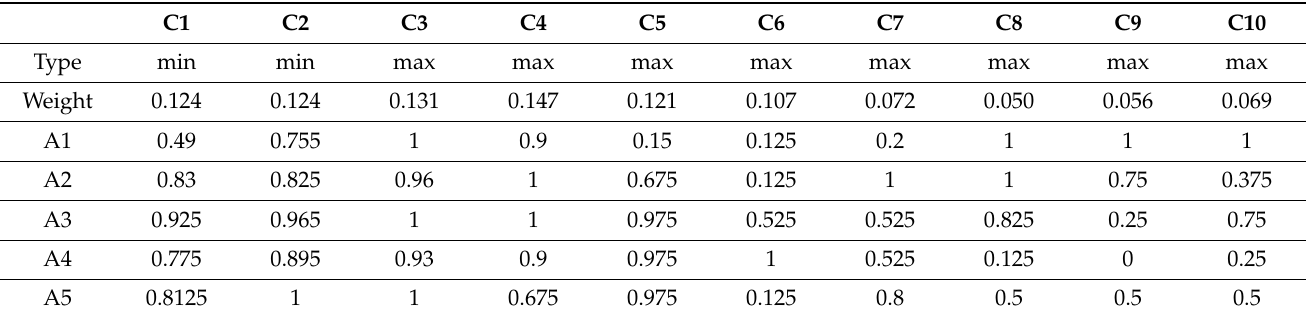
Table 13. Initial decision-making matrix.